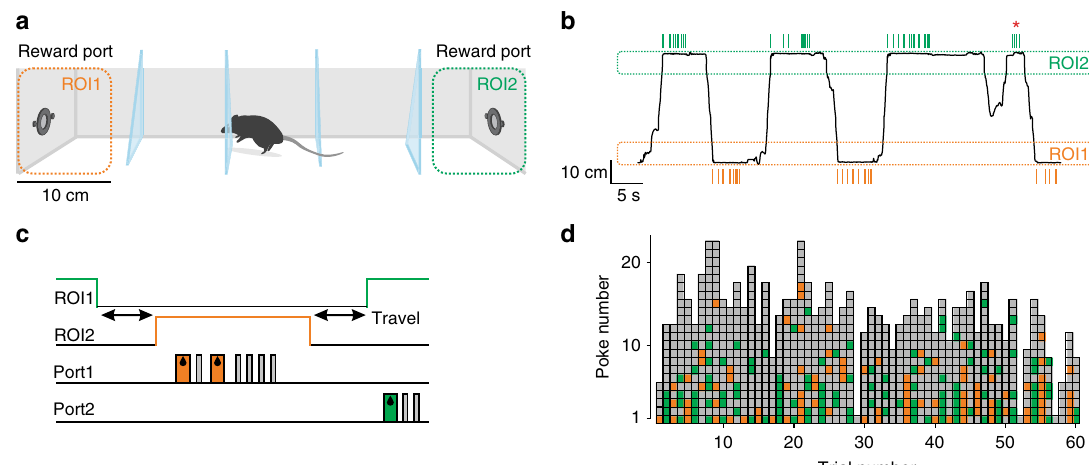
Fig. 1 The probabilistic foraging task. a Schematic drawing of the foraging task apparatus. Mice shuttle back and forth between two reward sites, located at the opposite ends of an elongated box, to obtain water rewards. b Example snapshot of foraging behavior. The one-dimensional location of an example mouse along the long axis of the box is plotted as a function of time. The ROIs around each water port are marked as dashed rectangles, and green and orange ticks above and below the trajectory mark nose-pokes into the right and left ports, respectively. The red asterisk marks an error trial. c Task events during a single trial. Each trial starts with an exit from one of the ROIs. Following shuttling to the other end, the mice would nose-poke multiple times and receive reward on some of the attempts on a probabilistic basis, before switching back. Green and orange rectangles mark rewards, gray rectangles mark omissions. d Example session, this time showing only the sequence of outcomes during nose-poking. Each column represents a single trial. Green/orange squares represent rewarded nose-pokes, gray squares,